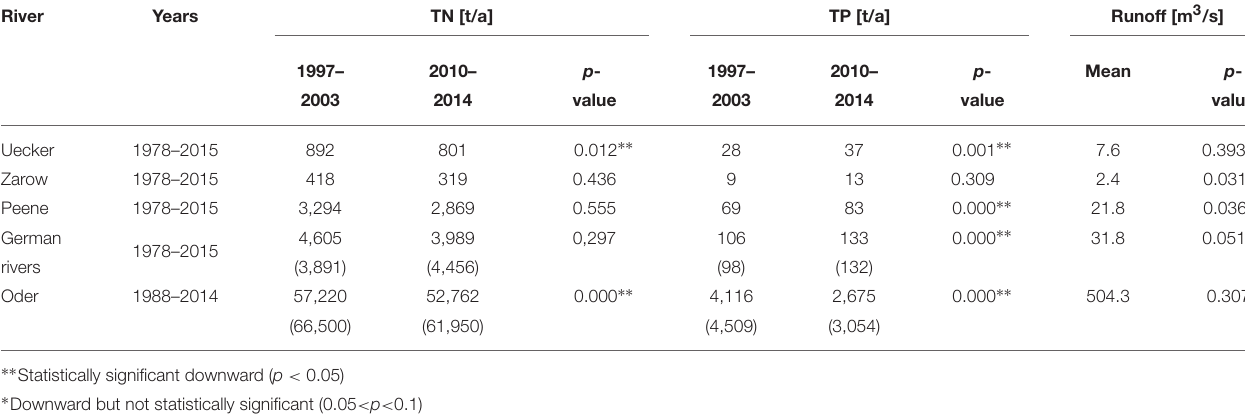
TABLE 1 | Flow-normalized loads to Szczecin Lagoon for the reference period (1997–2003) and recent times (2010–2014), values in brackets indicate the loads without